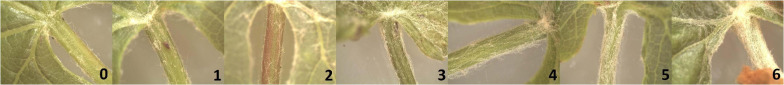
A representative visual scale to rate ribbon trichome density on adaxial petiole on first mature leaf samples.